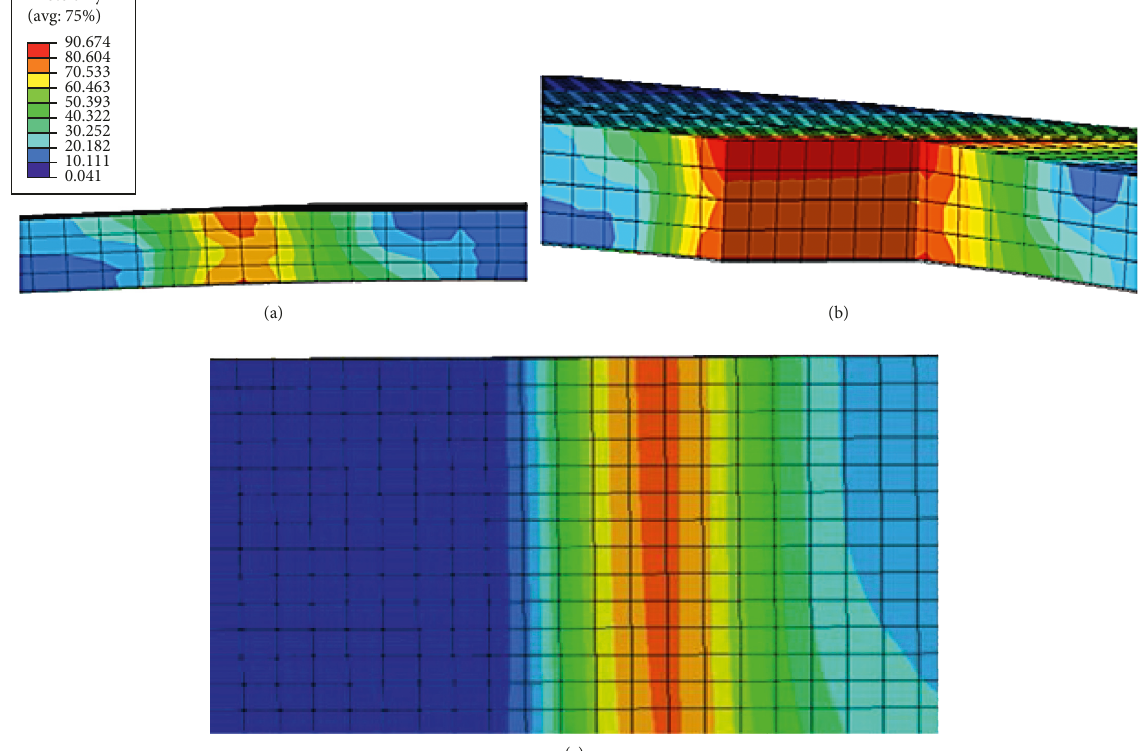
Figure 13: The distribution of equivalent stresses in the thermal deformation hearth (a, b) and in the zone of tape contact with the surface of the part (c) in the electrocontact surfacing of the steel strip at K v